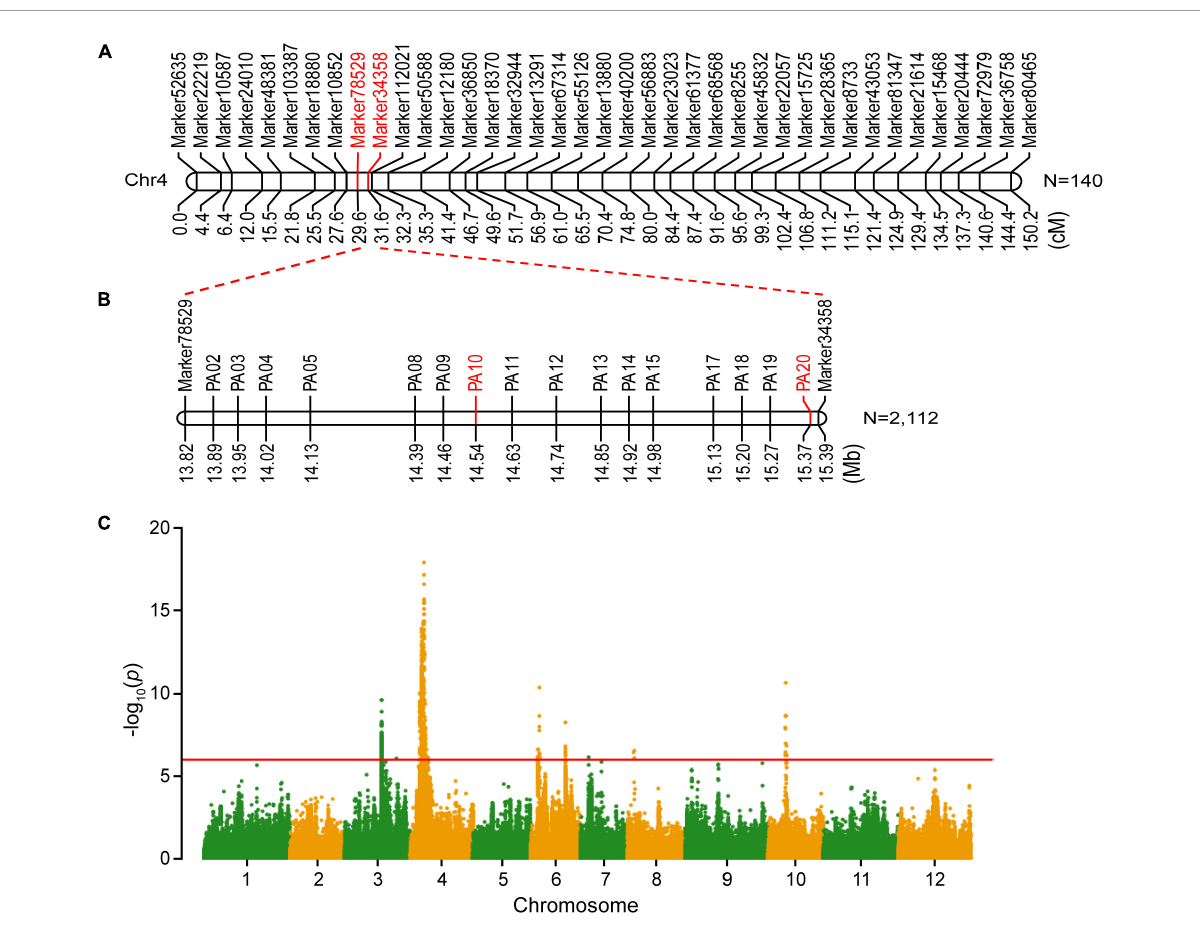
FIGURE2 Genetic mapping and genome-wide association study (GWAS) of the seed shape gene in the wax gourd. (A) Initial genetic mapping of the seed shape locus. (B) Fine mapping of the seed shape locus. (C) Manhattan plots of seed shape through